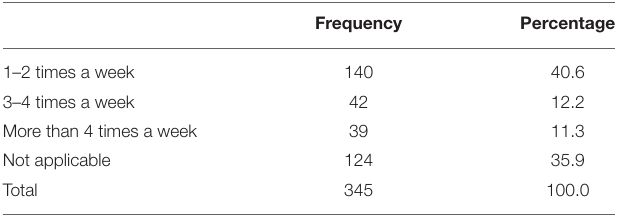
TABLE 12 | Frequency of usage of the computer lab among the students (Before COVID-19 pandemic).